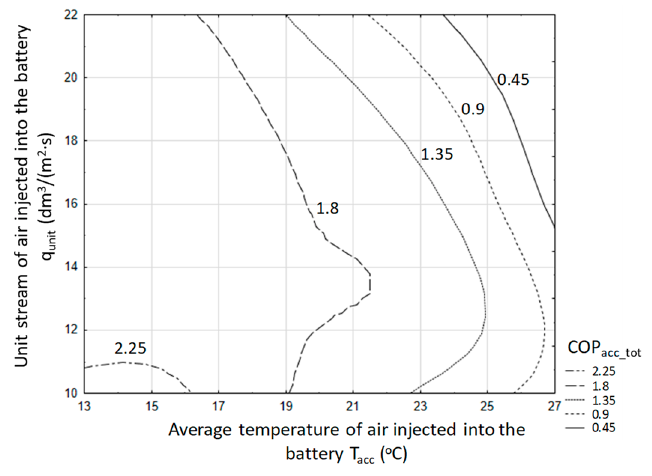
Figure 16. The course of the COP coefficient taking into account the charging and direct discharging of a stone-bed accumulator.